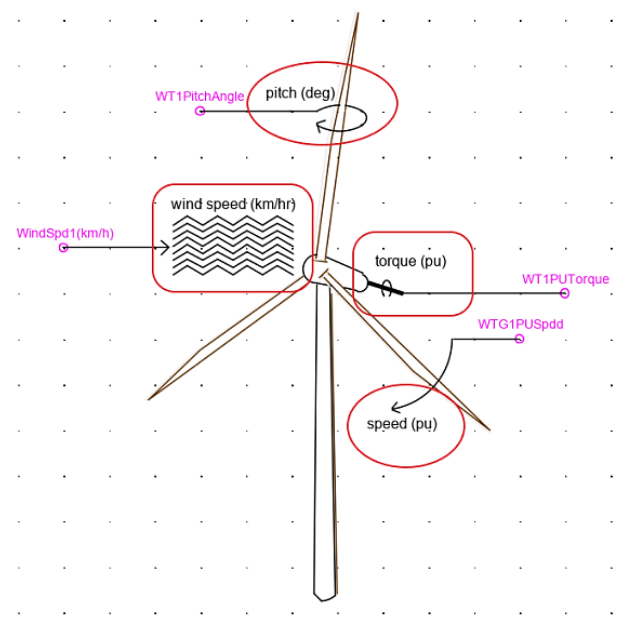
Figure 5. Upwind horizontal axis wind turbine, Vestas V117 - 4.2 MW.